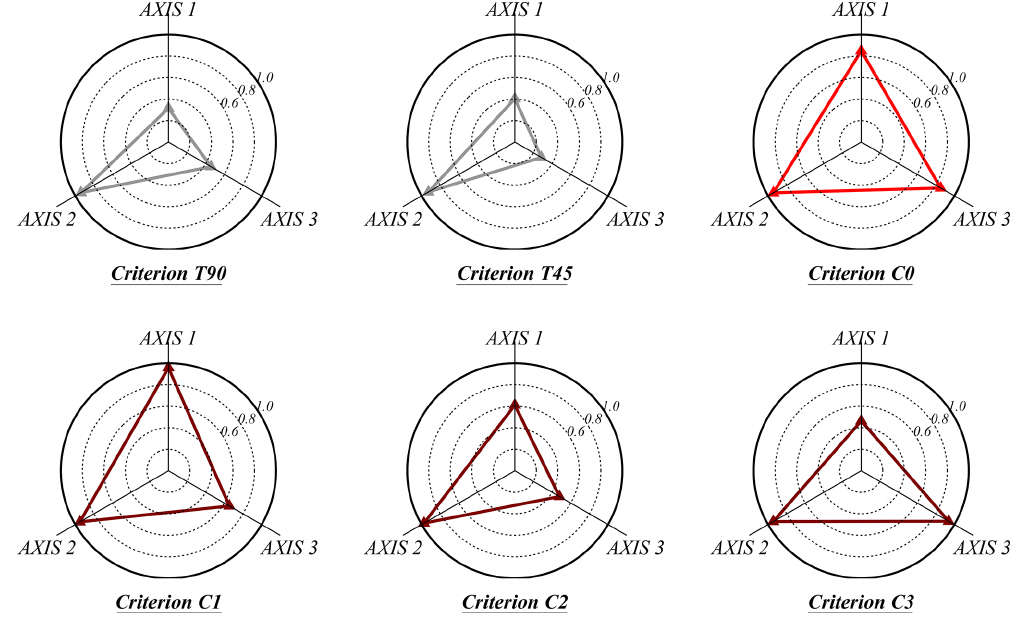
Figure 8. Indicators p 1 (axis 1), p 2 (axis 2), and p 3 (axis 3) for each criterion considered. value of the design agent expressed as C = K x n is the design value in each section and K is a constant.